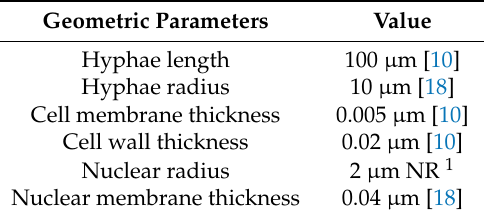
Table 2. Fungal cell geometric